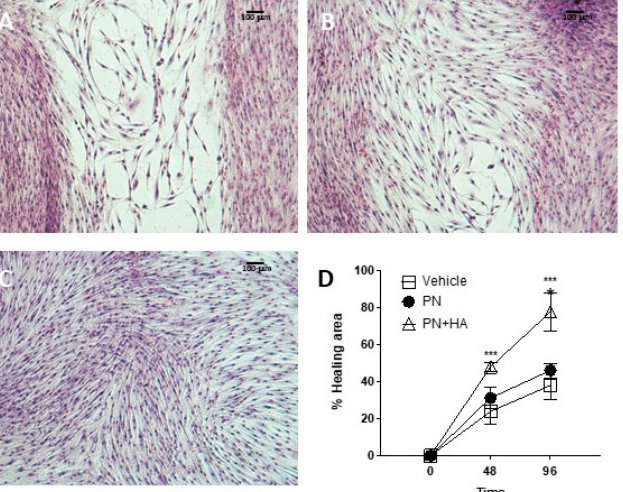
Figure 5. ( A – C ) Microphotographs of gingival fibroblasts, after scratch, cultured with vehicle ( A ), PN ( B ) or PN + HA ( C ) and stained with Giemsa. Magnification 4 × (Bar = 100 µ m). ( D ) Graph showing the amount of healing area (scratch area covered by cells) at time = and after 48 or 96 h. *** p < 0.001.